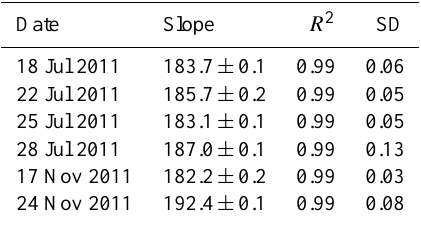
Table 1. Linear fit between lidar and co-located radiosondes mea- surements. Calibration of lidar water vapour profiles was obtained using data between 1.5 and 4.0km